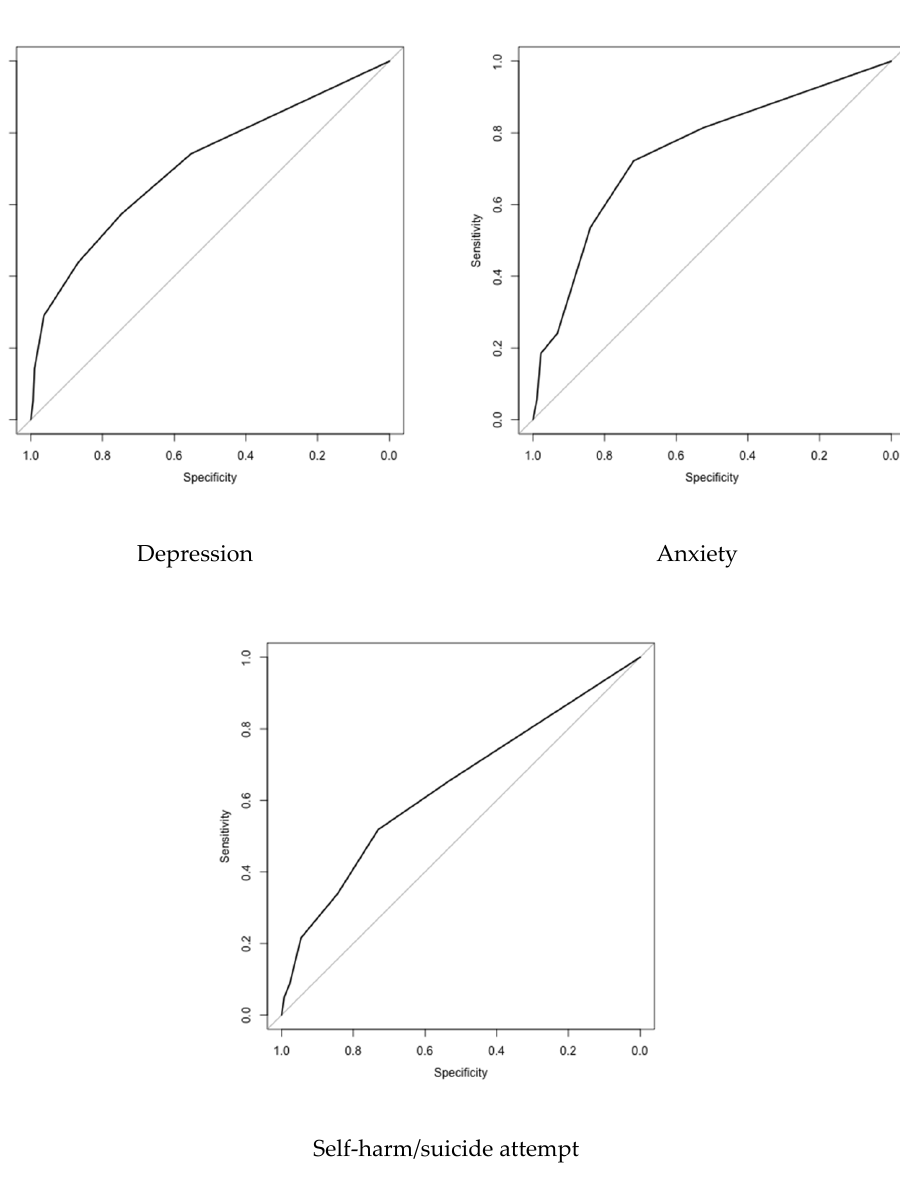
Figure 1. ROC curves plotting the sensitivity and specificity of the 3-item UCLA Loneliness Scale in classifying mental health problems. ( A ) Age-18 sample. ( B ) Age-38 sample.